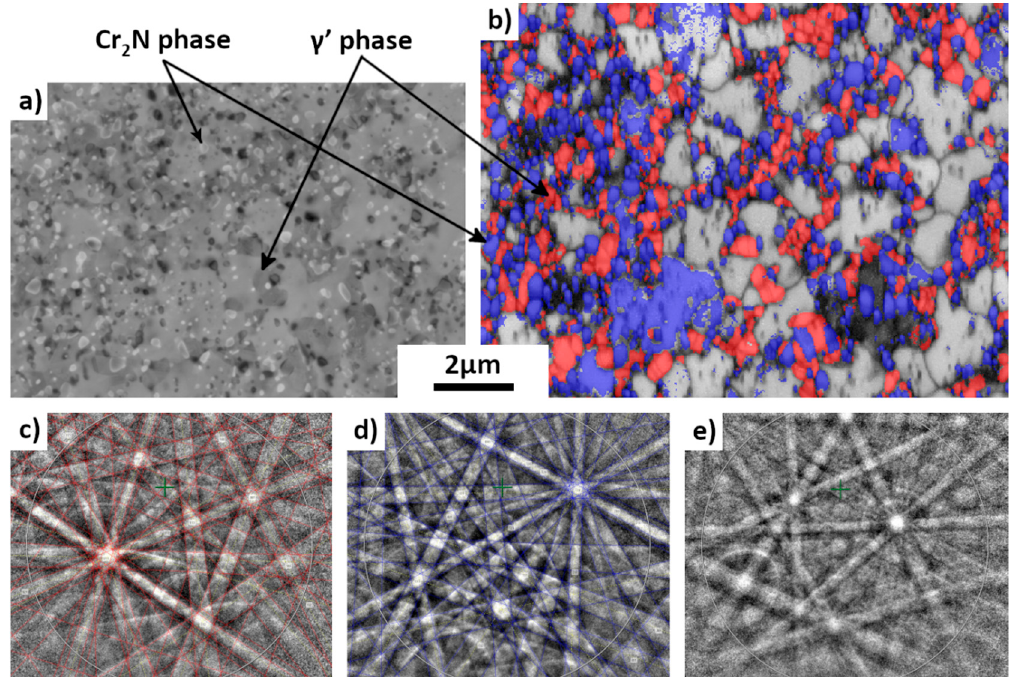
Figure 10. BSE ( a ) and EBSD ( b ) micrographs of same area of an 85% deformed sample after annealing at 575 °C for 398h. In EBSD micrograph (step size 50 nm), red: austenite phase, blue: Cr 2 N phase and gray (band quality indexed contrast): unknown phase. Corresponding EBSD Kikuchi patterns of the three phases: ( c ) austenite, ( d ) Cr 2 N, ( e ) unknown phase. For austenite and Cr 2 N, calculated line patterns are superimposed with experimentally acquired patterns showing the excellent fit.